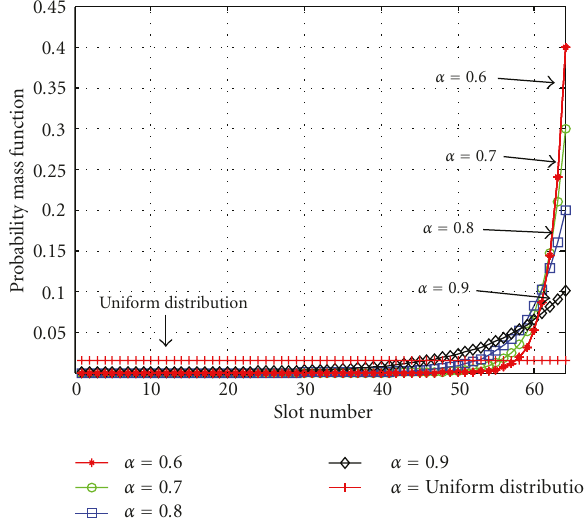
Figure 5: Di ff erence between uniform and truncated geometric distributions (this result is taken from